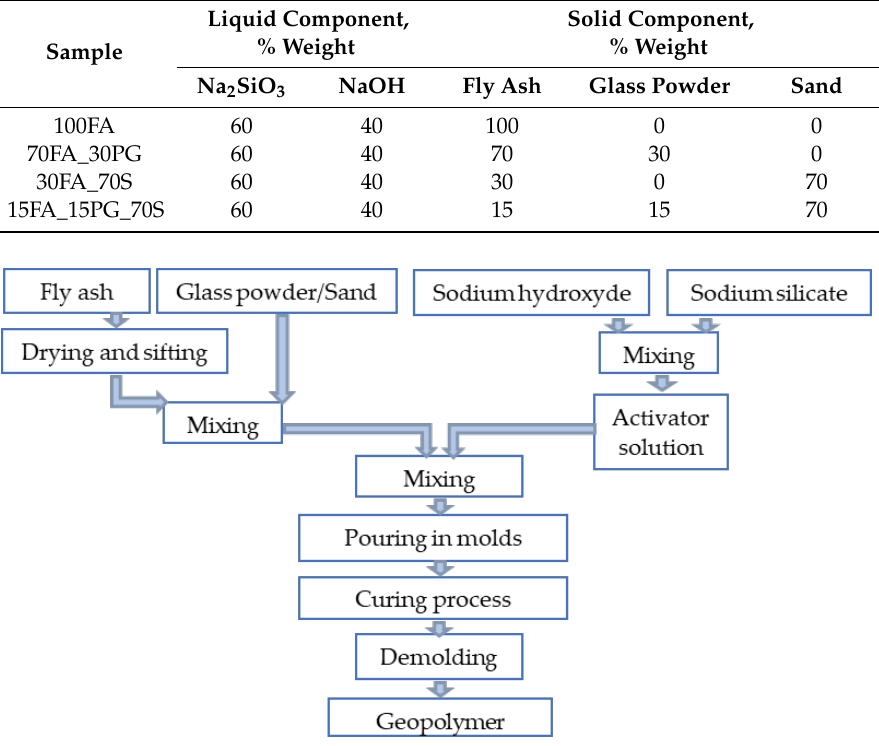
Figure 3. Process flow diagram.